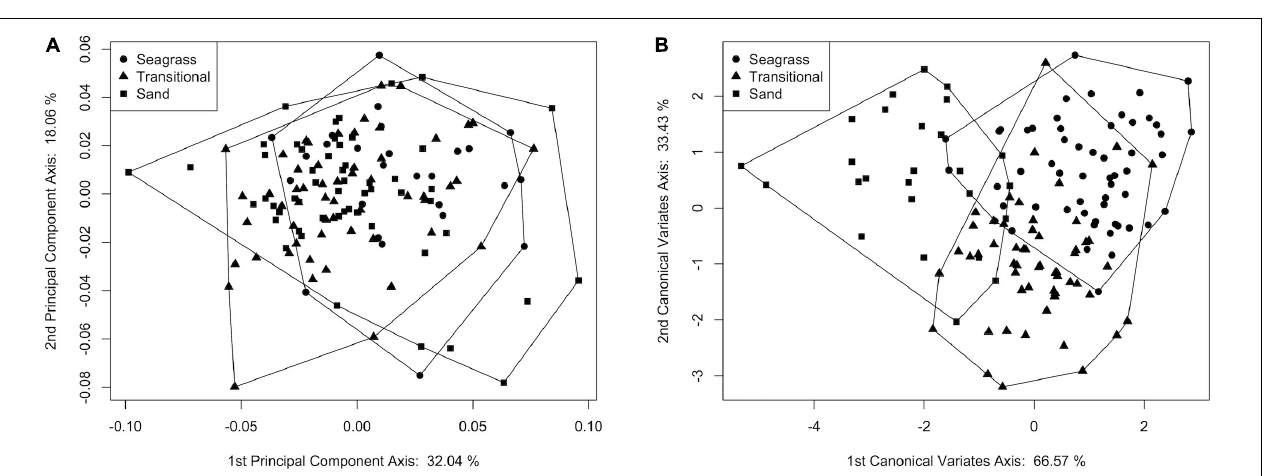
FIGURE 5 | Plots of (A) principal component axis 1 vs. principal component axis 2 scores and (B) canonical variate axis 1 vs. canonical variate axis 2 scores for live S. floridana assigned to stability